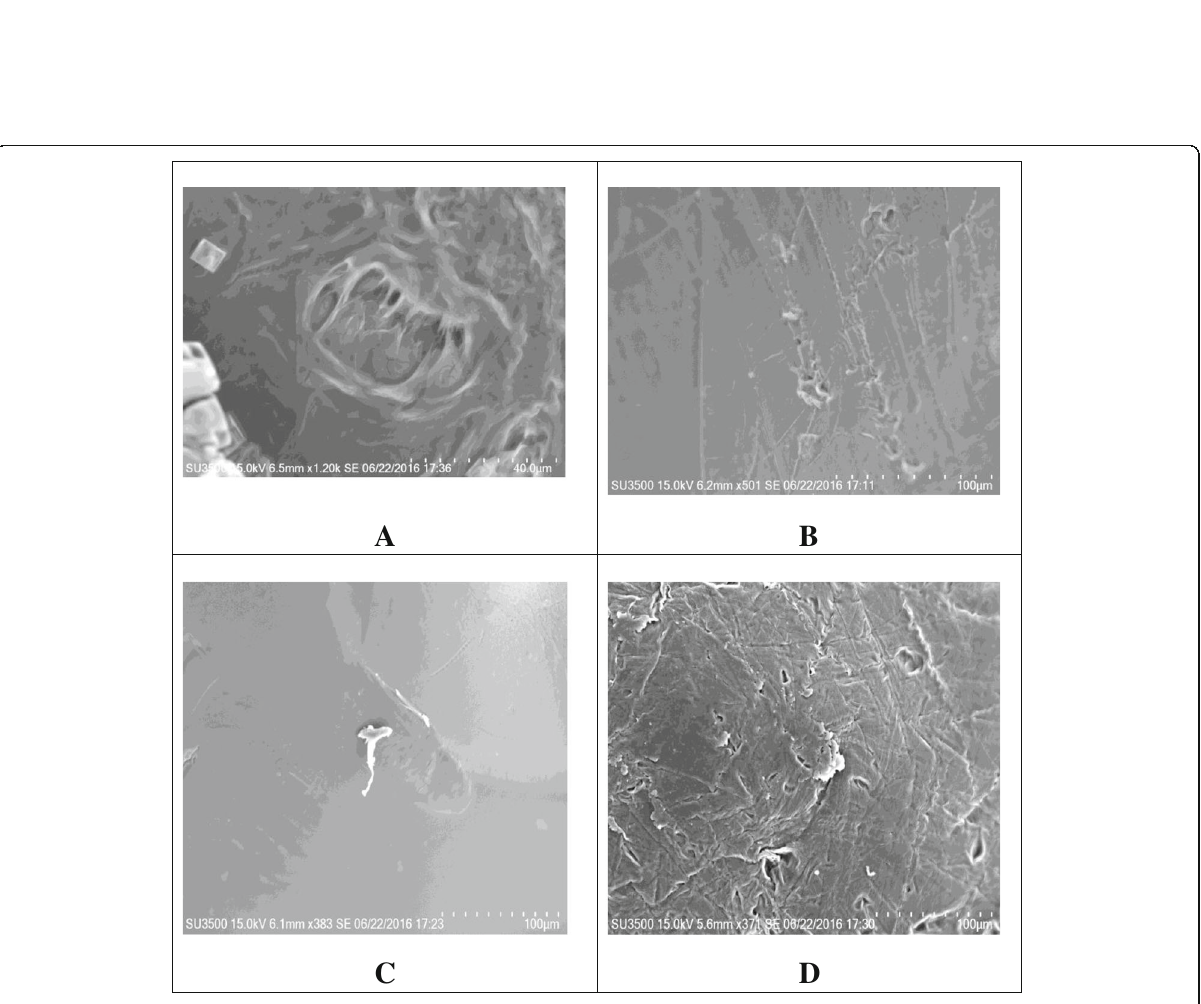
Fig. 13 SEM for carrageenan ( a ), aminated carrageenan ( b ), activated carrageenan ( c ), and enzyme immobilized on carrageenan ( d